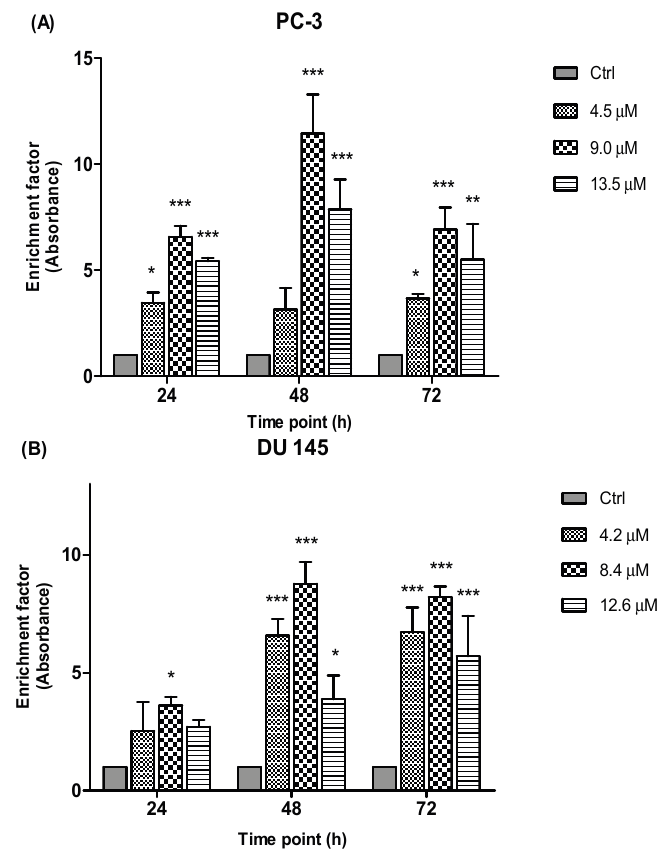
Figure 10. Enrichment of nucleosomes in MS17-treated ( A ) PC-3 and ( B ) DU 145 cells at 24, 48 and 72 h incubation. Results are expressed as mean ratio ± S.E. of the absorbance from cells treated with MS17 relative to absorbance of untreated cells and comparison between data sets was performed using ANOVA. * p < 0.05, ** p < 0.01 and *** p < 0.001 indicates statistically significant differences between the means of values obtained with treated vs. control. Samples were run in duplicates and comparable results obtained from two independent